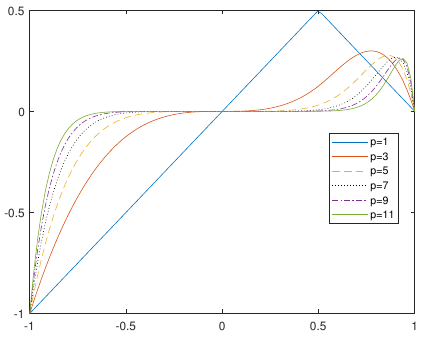
Figure 8. Local maximum of τ p